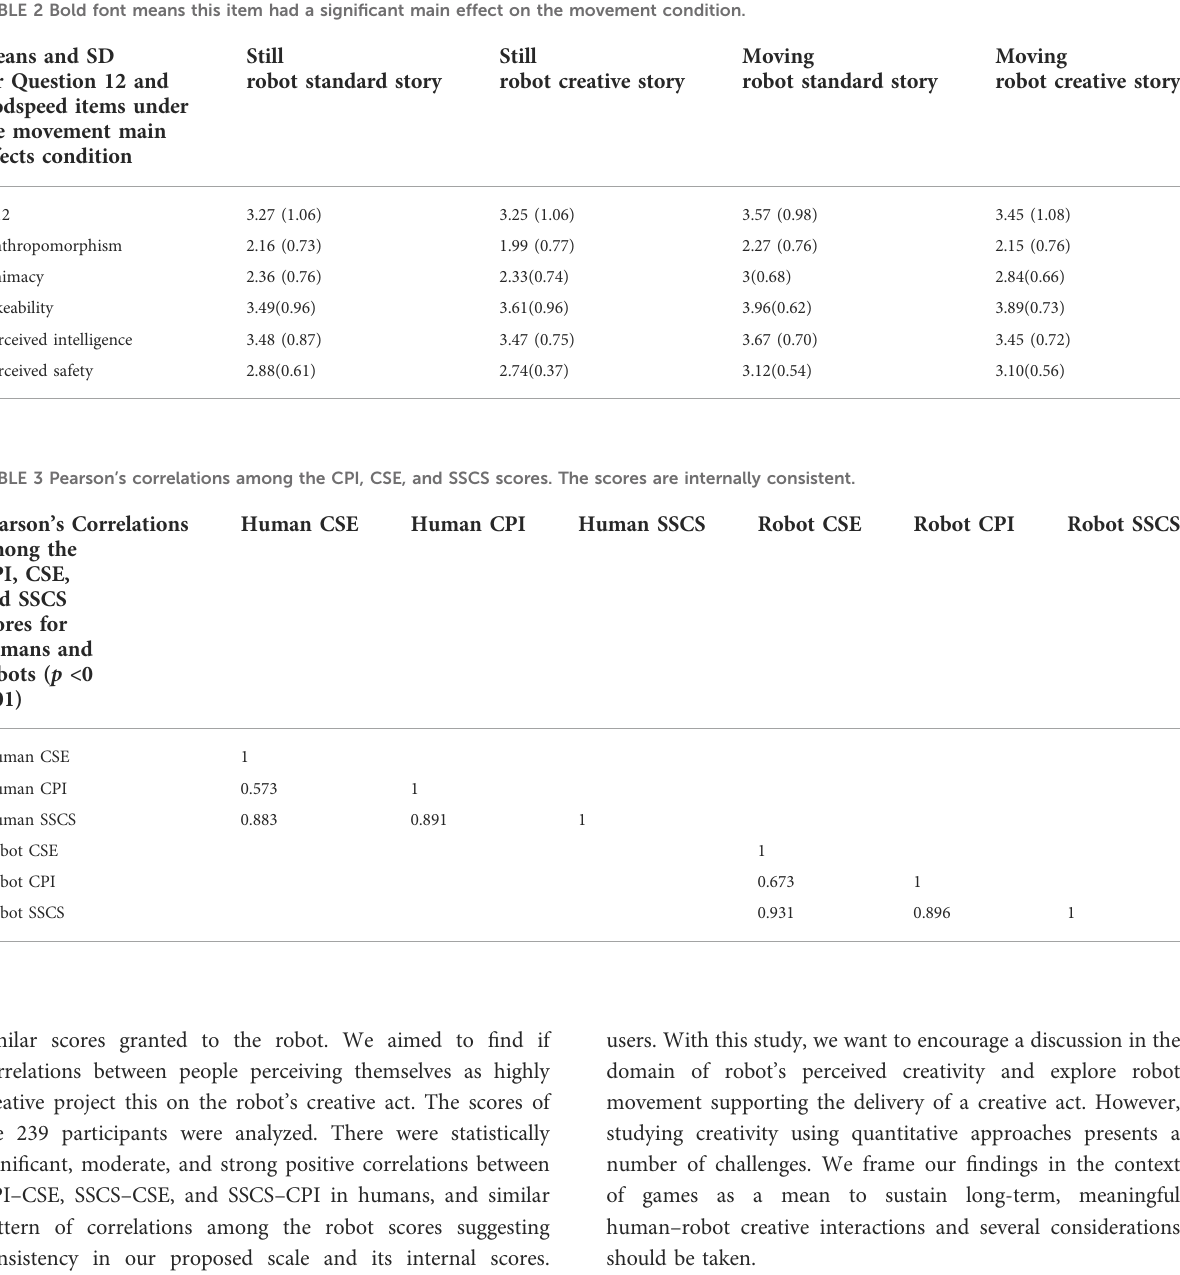
TABLE 2 Bold font means this item had a signi fi cant main effect on the movement condition. Means and SD for Question 12 and Godspeed items under the movement main